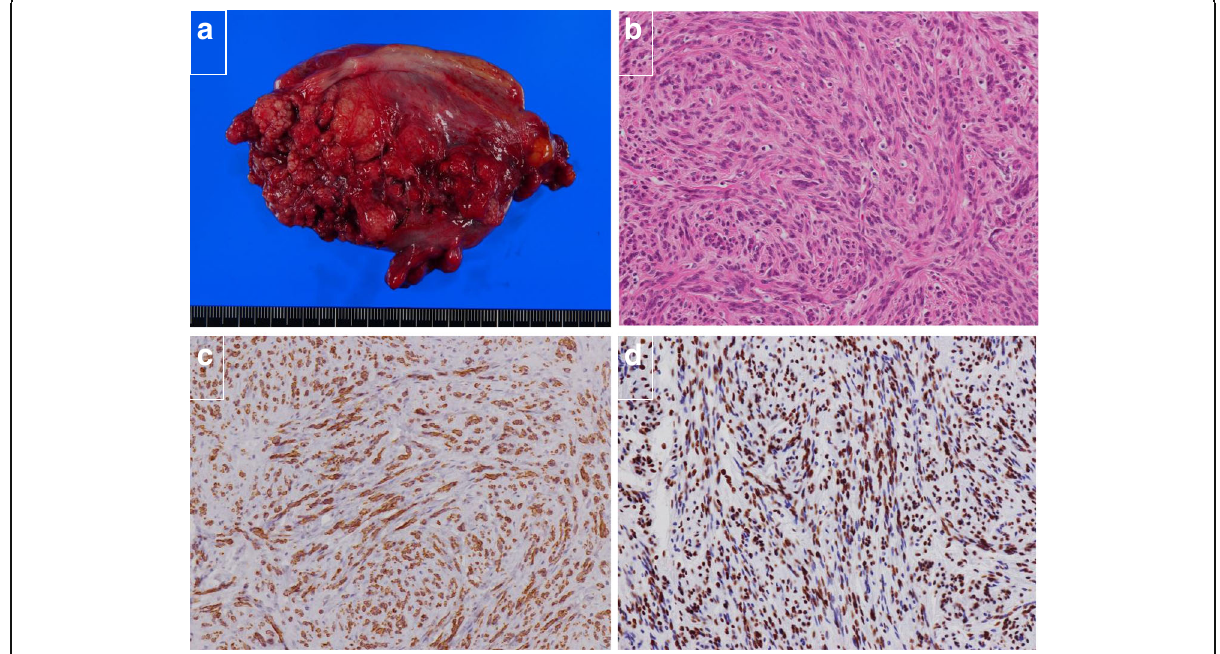
Fig. 5 a Macroscopic finding of the tumor of broad ligament. A tumorous mass composed of numerous ill-defined or fused small nodules. b Microscopic finding of the tumor of broad ligament (HE × 20). Spindle cells with eosinophilic cytoplasm that resemble smooth muscle cells. c Immunohistochemical analysis of the pelvic lesion. They were positive for smooth muscle actin. d They were positive for